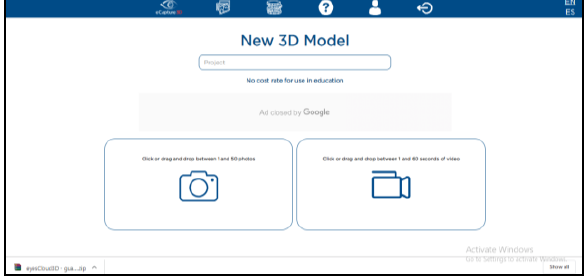
Figure 5. EyesCloud3D a platform to upload video to generate point clouds